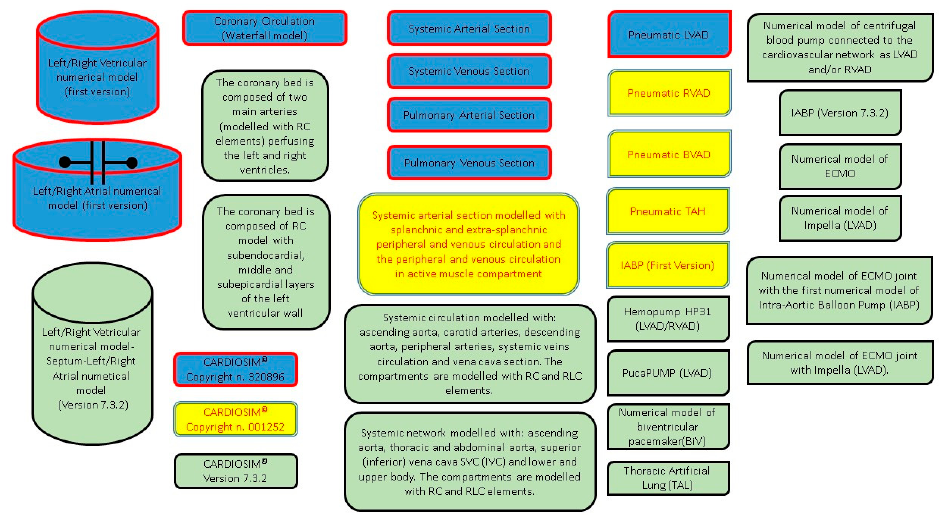
Figure 4. Graphical representation of all the modules implemented in CARDIOSIM © software simulator. Blue modules were implemented in the first version (copyright n. 320896). Blue and yellow modules were implemented in the second version (copyright n. 001252). All modules (blue, yellow and green) are implemented in the latest version